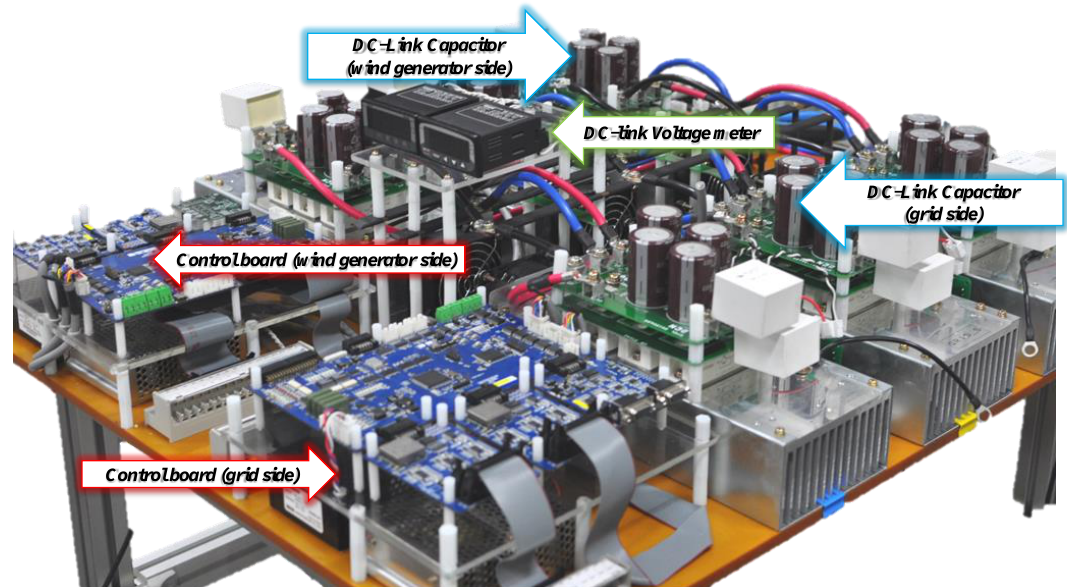
Figure 26. Configuration of the experimental system.